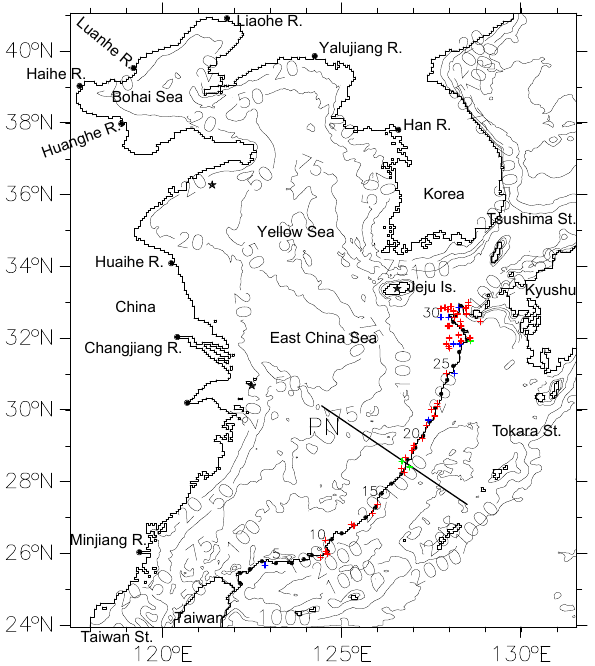
Fig.1 Fig. 1. Model domain and bathymetry. Rivers are denoted by dots around the coastline; three observation sites for atmospheric dry and wet deposition of nutrients are denoted by stars; and observation stations for the data used in Fig. 8 are denoted by crosses. Red means data number less than 10, blue means data number between 10 and 40, and green means data number more than 40. Numbered contours are isobaths in meters. The 200-m isobath along the shelf break is overlapped by a line with dots and numbers, across which the fluxes of volume and nutrients are calculated and presented in Figs.